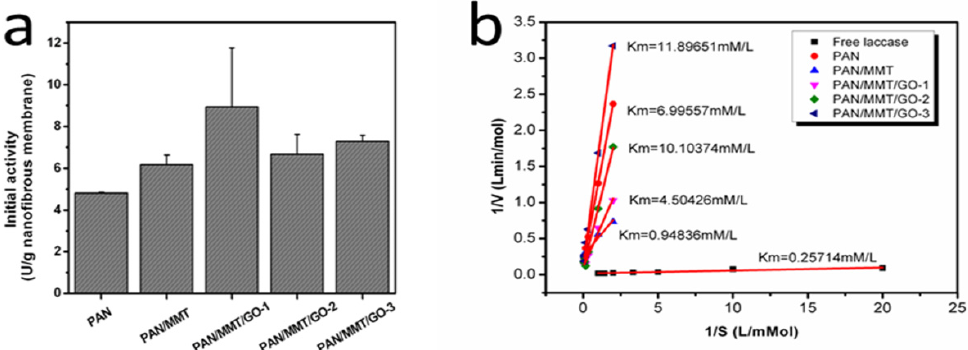
Figure 4. The activities of immobilized laccase on PAN, PAN/MMT, PAN/MMT/GO composite nanofibers in an aqueous buffer solution (pH 4.5, temperature 30